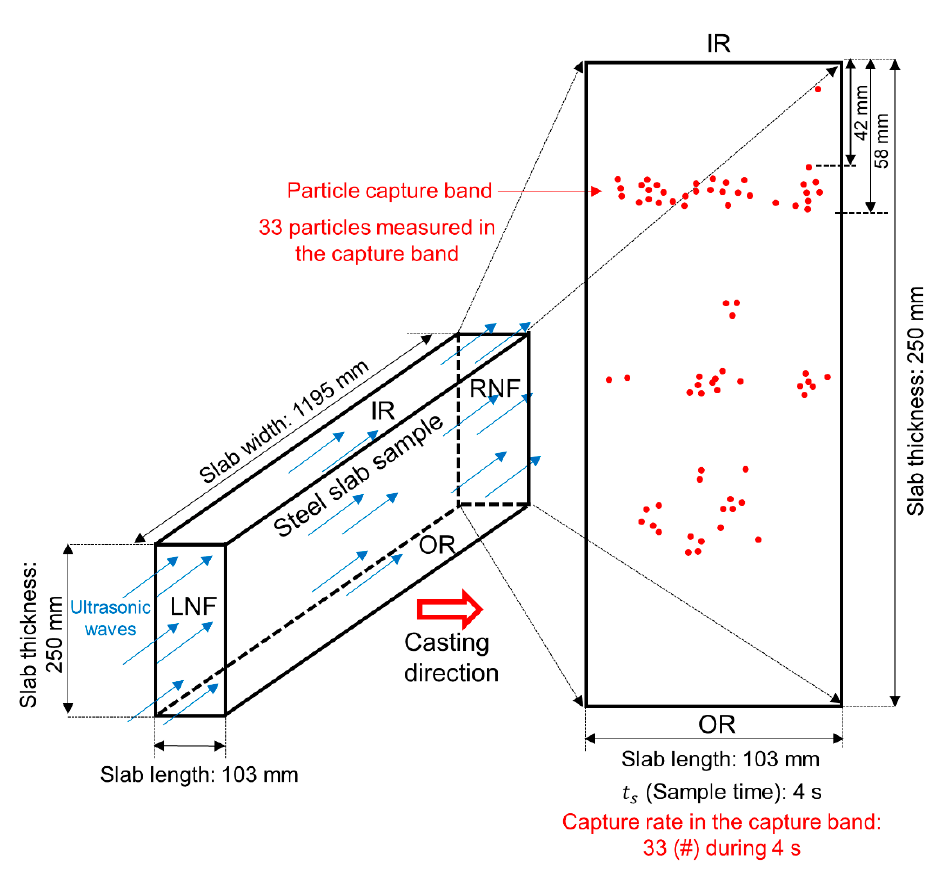
Figure 12. Particle capture locations in the steel slab sample, based on UT measurements (side view).